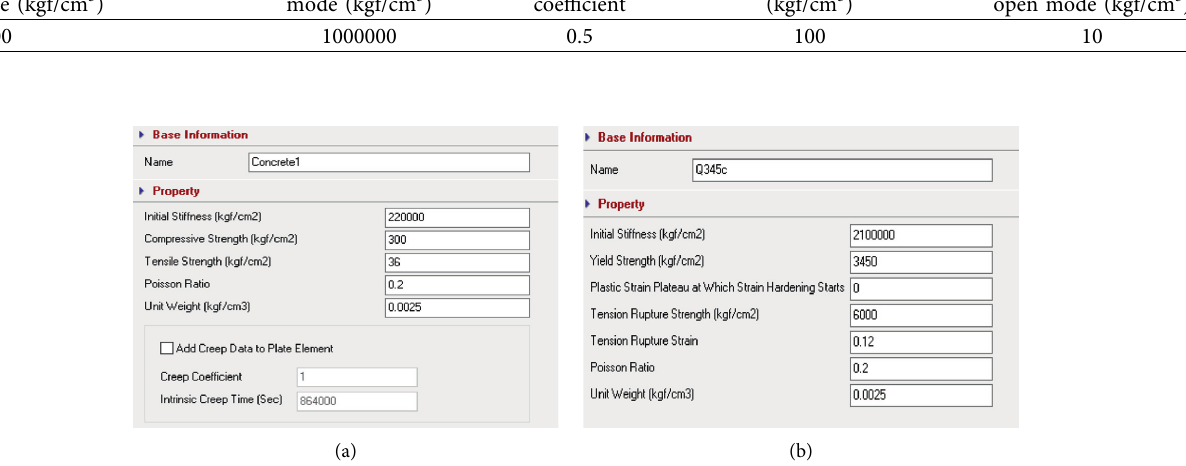
Figure 19: Material properties of the model: (a) material properties of the concrete element and (b) material properties of the steel plate element.